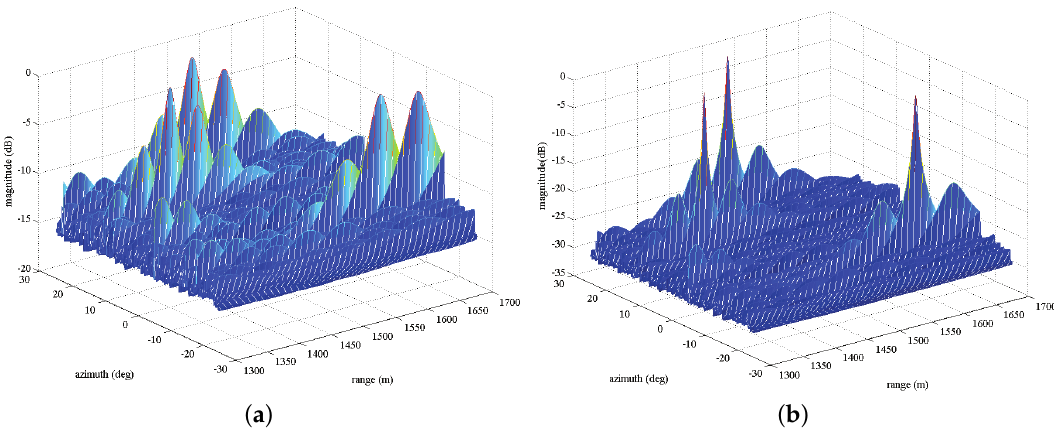
Figure 4. Two-dimensional MVDR spatial spectrums for three calibration sources, ( a ) before calibration; ( b ) after